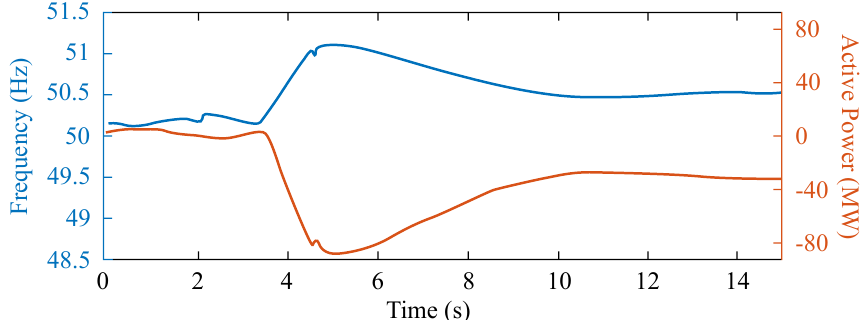
Figure 11. Frequency support of the Hornsdale Power Reserve (HPR) to 31 January 2020 separation event (plot drawn with data from